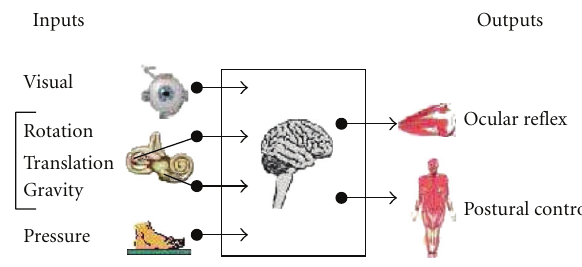
Figure 1: Schematic diagram of the balance